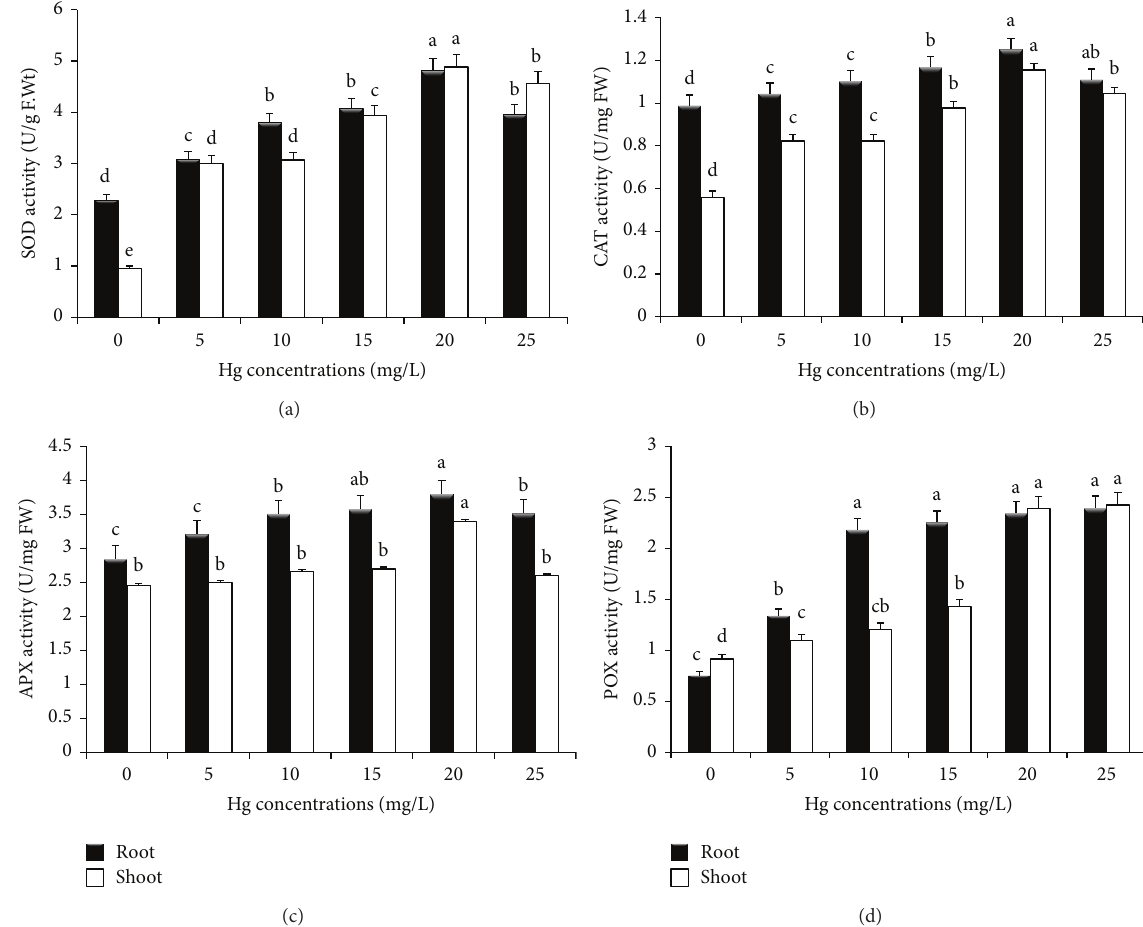
Figure 2: Effect of mercury heavy metal induced stress on SOD (a), CAT (b), APX (c), and POX (d) activities of M. arvensis seedlings after 12 days of treatment along with untreated control. Values are means ( 𝑛 = 3 ) ± SE; bars followed by the same letters are not significantly different for 𝑃 ≤ 0.05 according to the Duncan’s